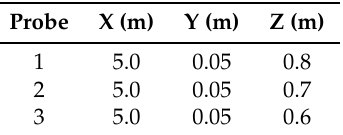
Table 1. Velocity probe positions for deep water simulations.